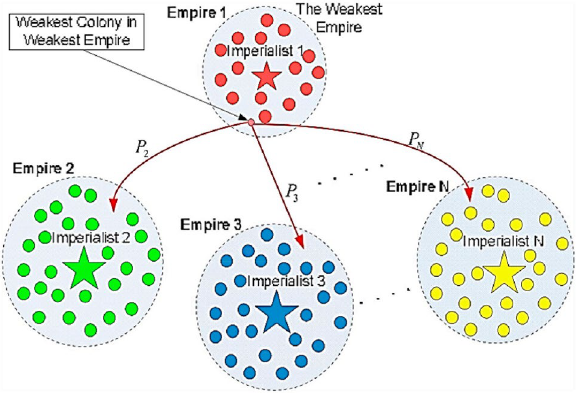
Figure 1. Schematic representation of the ICA optimization method 57